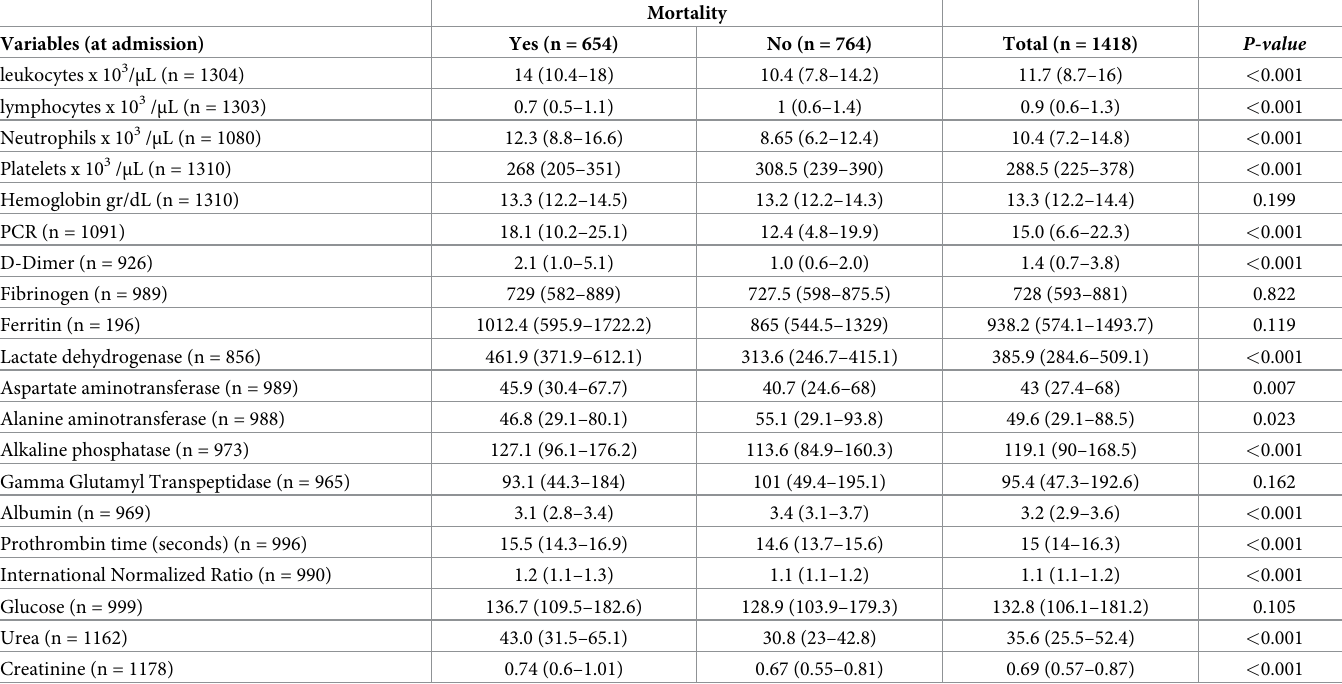
Table 4. Laboratory findings in patients with COVID-19 admitted to the Hospital Nacional Hipo´lito Unanue from April to August 2020. Lima, Peru. Mortality